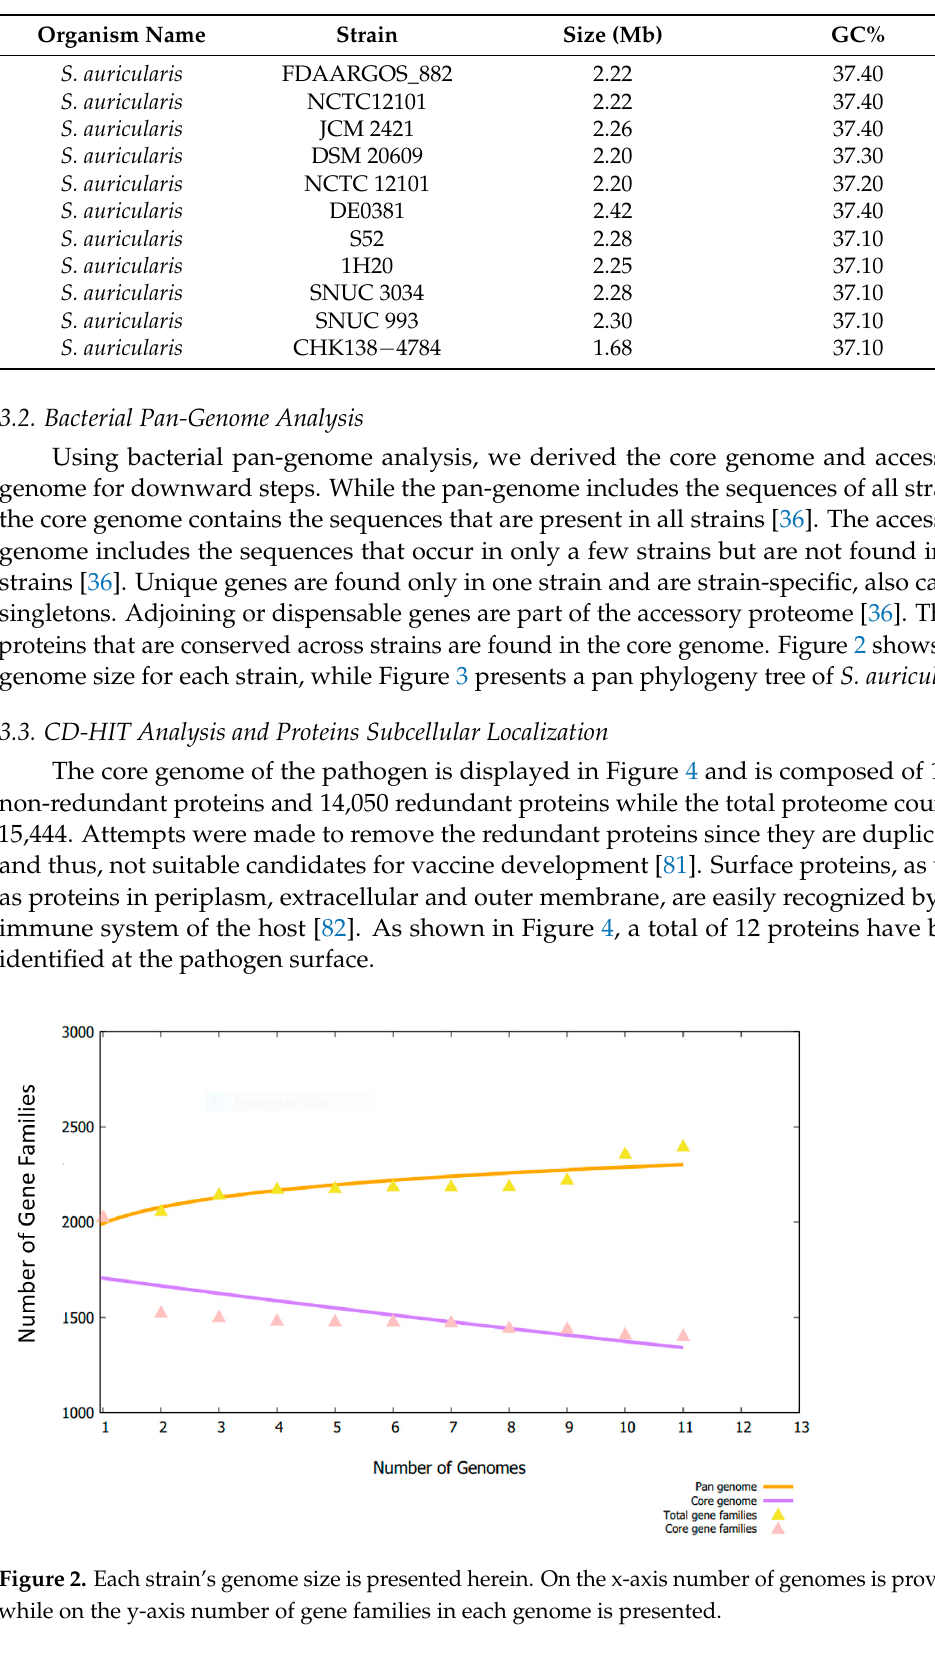
Table 1. S. auricularis strains with different statistics.